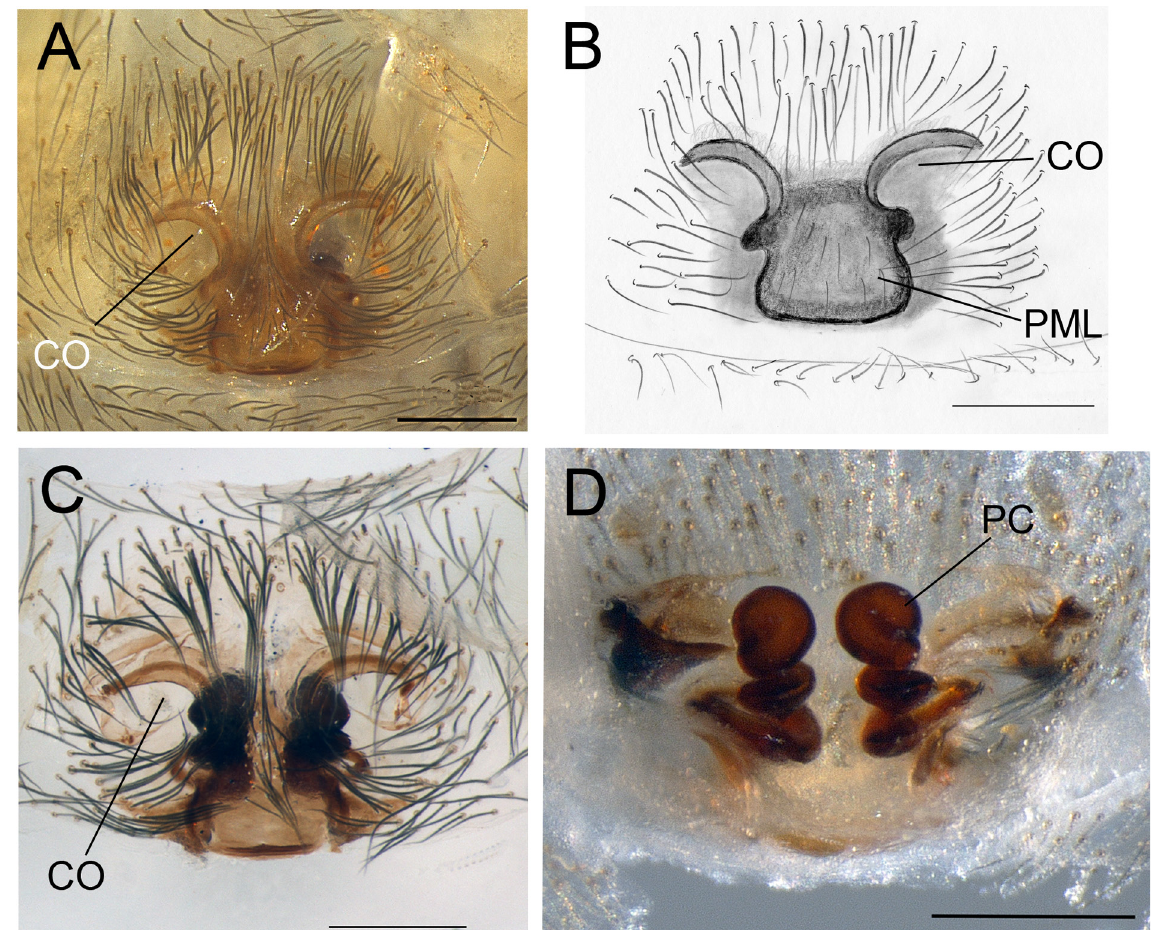
Fig. 5. Xevioso cepfi sp. nov., ♀, paratype (RMCA_ARA_245496), epigyne. A–B . Ventral view. C . Cleared, ventral view. D . Cleared, dorsal view. Abbreviations: CO = copulatory opening; PC = posterior chamber; PML = posterior median lobe. Scale bars = 200